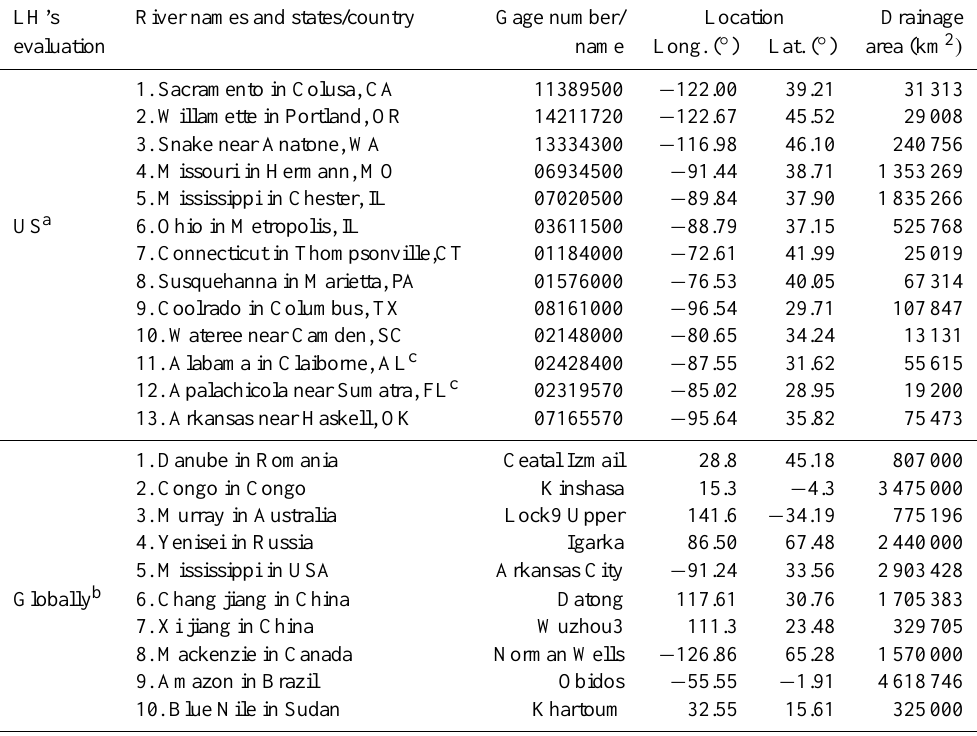
Table 4. Details of river gage stations used for model evaluation in both the US and globally.